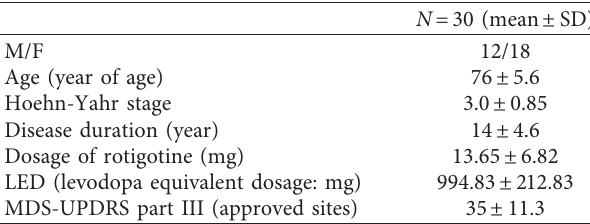
Table 1: Patients